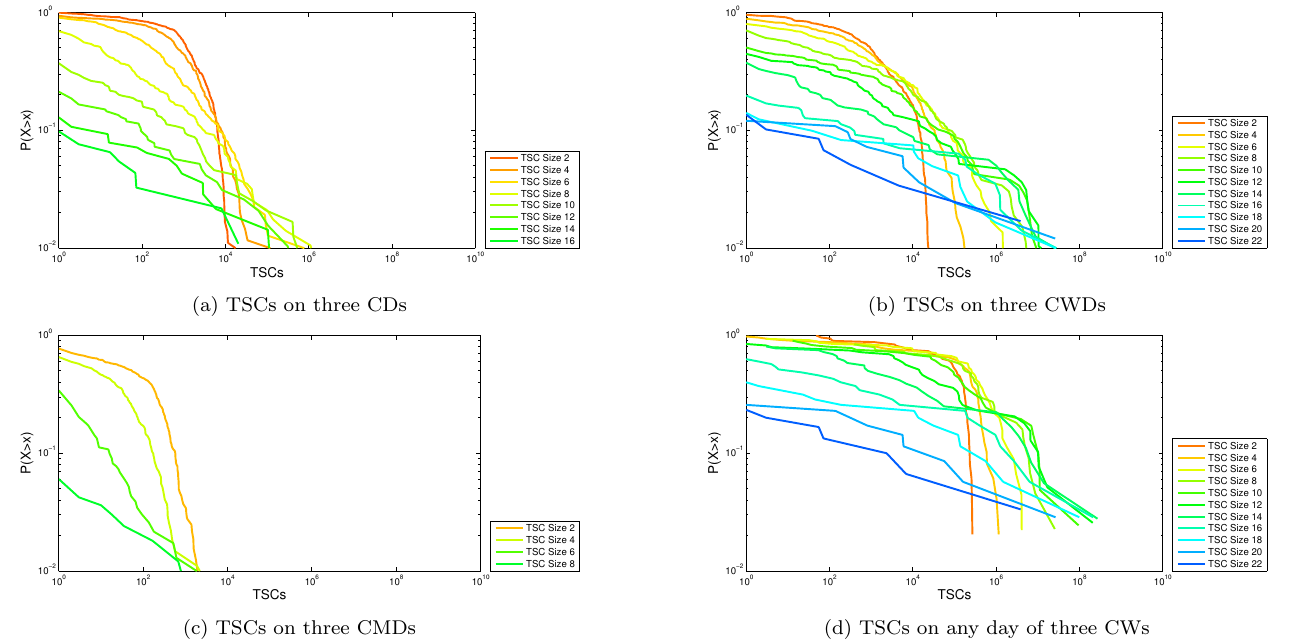
Figure 9: Temporal patterns for three consecutive